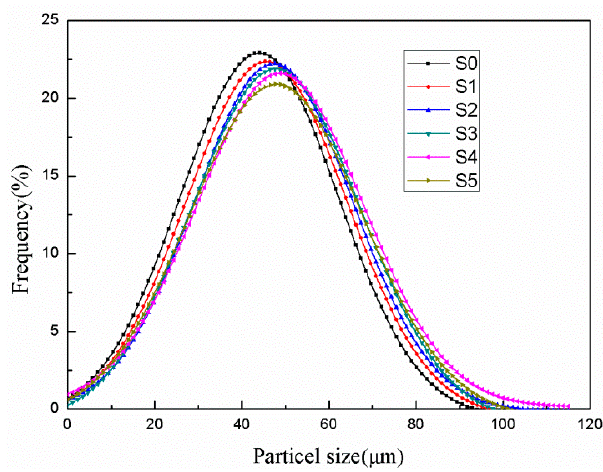
Figure 5. Particle size distributions of phase-change microcapsules (microPCMs) with different amounts of diatomite.